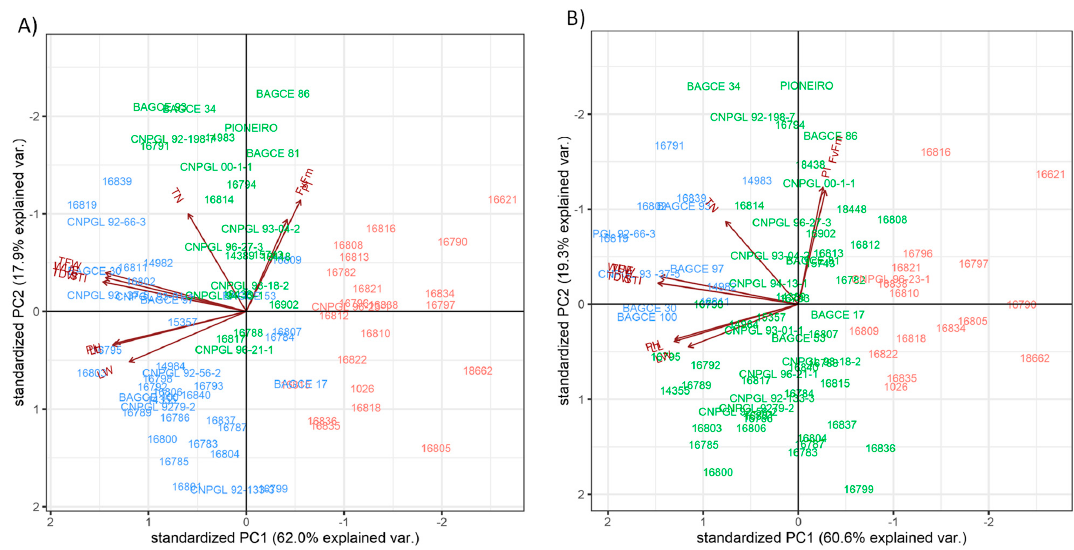
Figure 3. PCA biplots of morphological, physiological and agronomic traits of Napier grass genotypes growing under: ( A ) moderate water stress and ( B ) severe water stress. The color of genotypes indicates different cluster groups from the pattern analysis. The angles between the vectors indicate the degree of correlation between traits. Plant height (PH), leaf length (LL), leaf width (LW), chlorophyll fluorescence (Fv/Fm), performance index (PI), tiller number (TN), total fresh weight (TFW), total dry weight (TDW), water use efficiency (WUE) and stress tolerance index (STI).